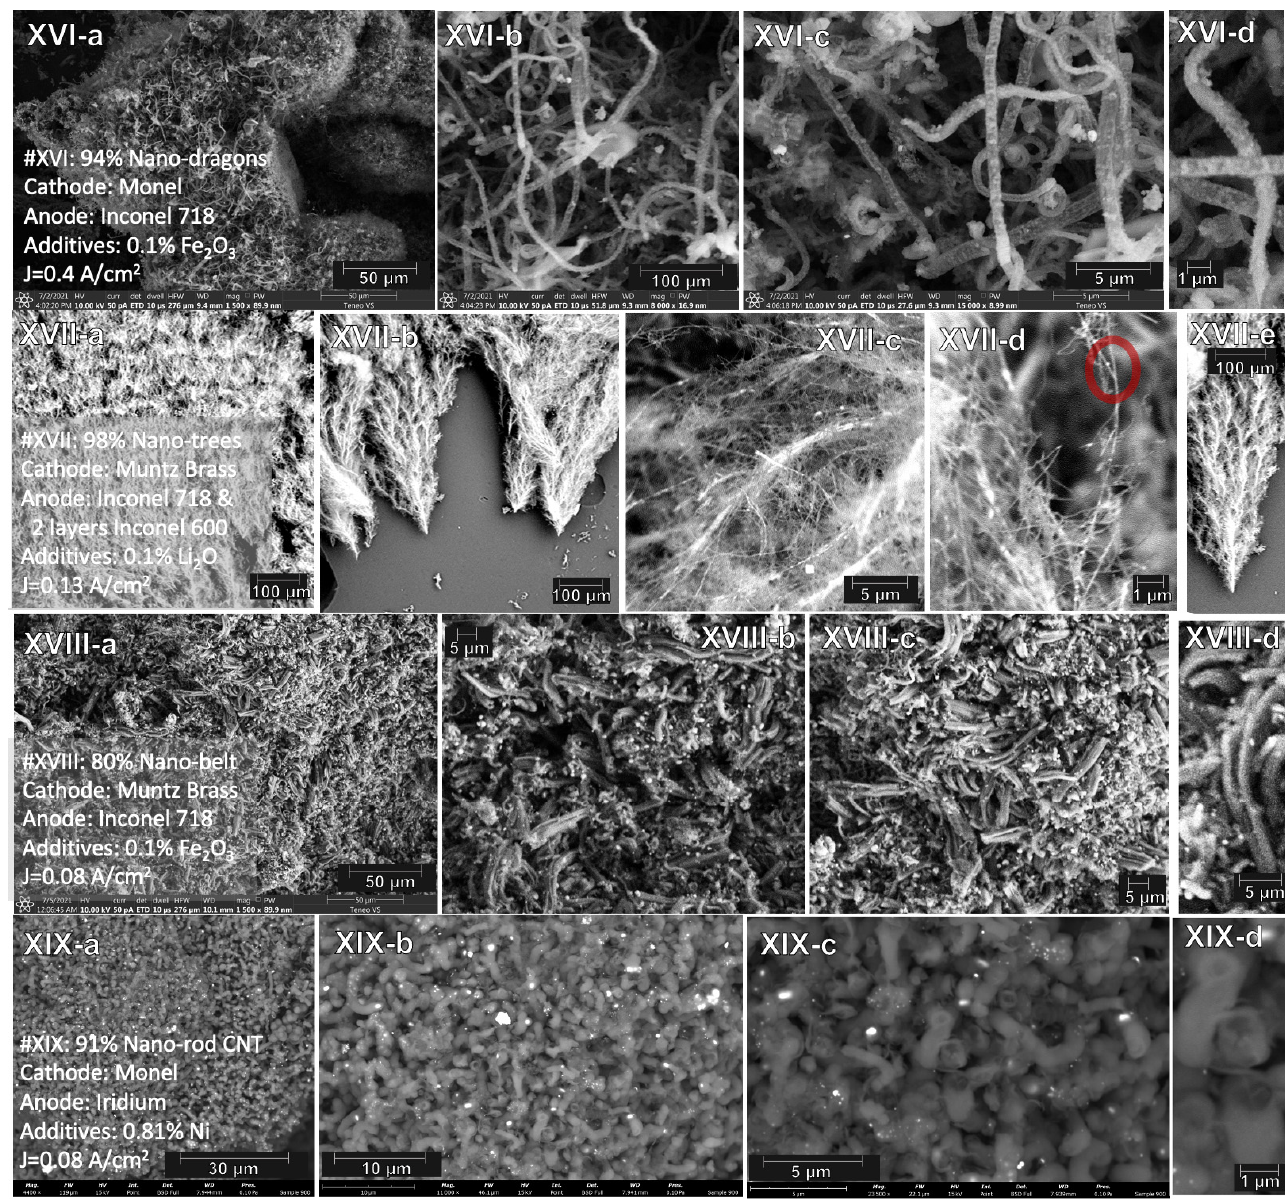
Figure 8. SEM of the synthesis product of nano-dragons, nano-trees, nano-belts and nano-rod allo- tropes of carbon by electrolytic splitting of CO 2 in 770 °C Li 2 CO 3 . Moving left to right in the panels, the product is analyzed by SEM with increasing magnification. Scale bars in panels (starting from left) are for panels k: 50, 10, 5 and 5 µm; for panels Q: 100, 100, 5, 1 and 100 µm; for panels Z: 50, 5 and 5 µm; for panels 9: 30, 10, 5 and 1 µm.